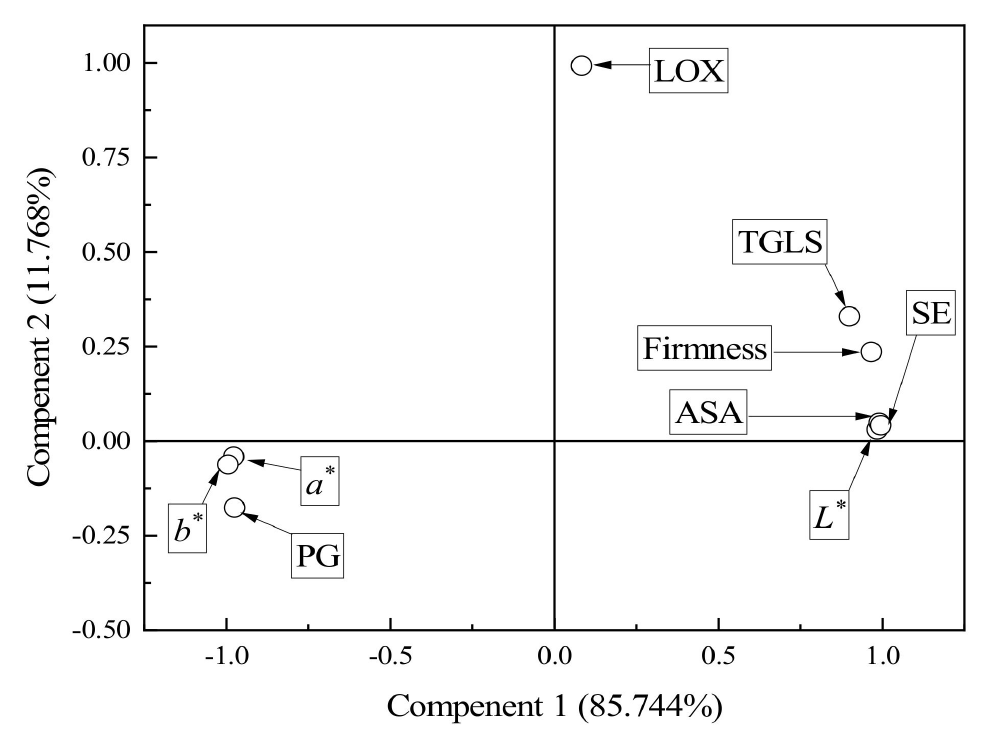
Figure 7. Principal component graph in rotating space. L* —lightness, a* —redness, b*